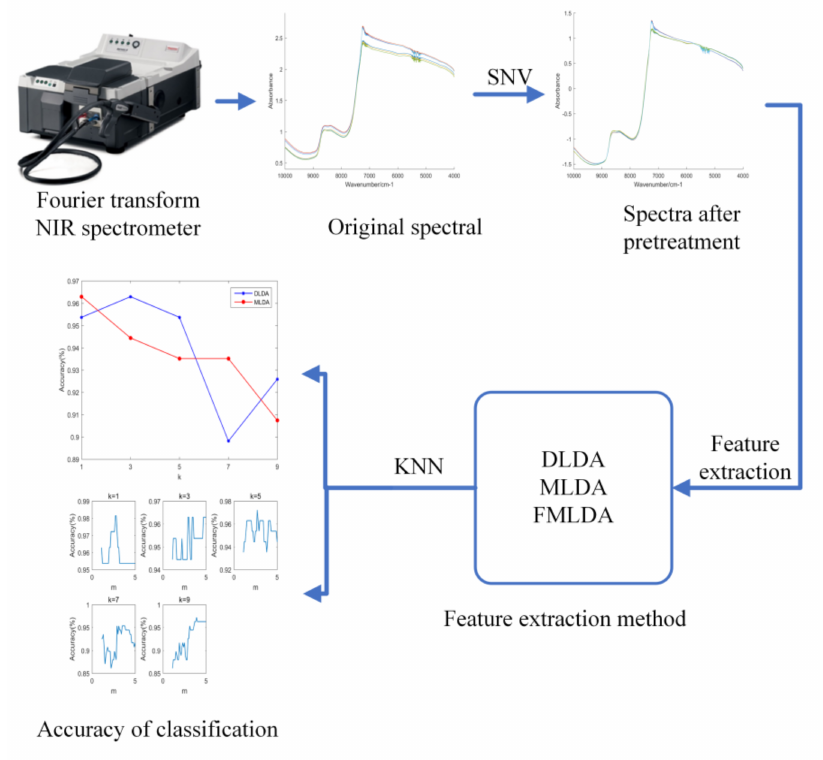
Figure 1. Flow chart of tea grade identification system based on feature extraction